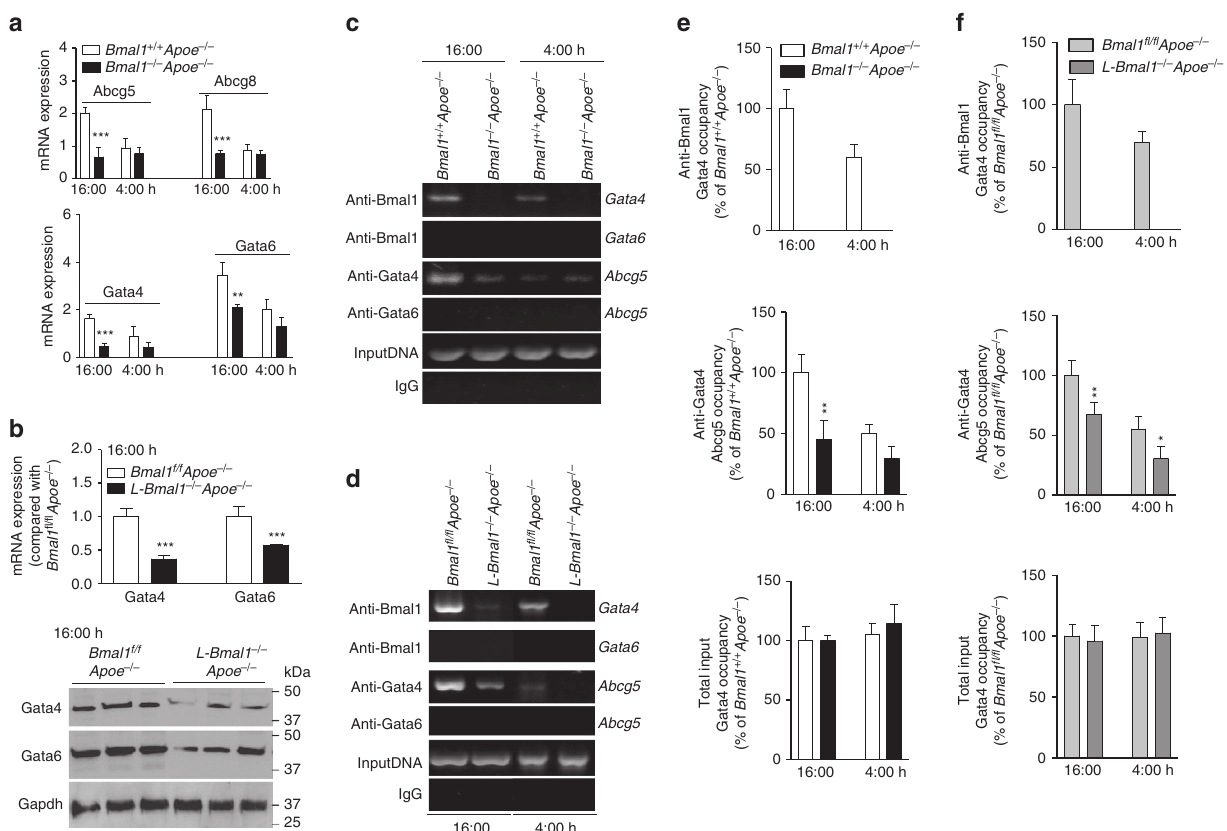
Figure 7 | Bmal1 interacts with the promoter to regulate Gata4 expression. ( a ) Liver samples were collected at 4:00h and 16:00h from Bmal1 (cid:2) / (cid:2) Apoe (cid:2) / (cid:2) and Bmal1 þ / þ Apoe (cid:2) / (cid:2) mice to measure temporal changes in the mRNA levels of Abcg5, Abcg8 (top), Gata4 and Gata6 (down). ( b ) Liver samples were collected at 16:00h from L-Bmal1 (cid:2) / (cid:2) Apoe (cid:2) / (cid:2) and control mice to measure mRNA (top) and protein (bottom) levels of Gata4 and Gata6. ( c ) Liver samples from Bmal1 (cid:2) / (cid:2) Apoe (cid:2) / (cid:2) and Bmal1 þ / þ Apoe (cid:2) / (cid:2) mice were collected at different times to study the binding of different transcription factors using indicated antibodies to the promoters of Gata4 , Gata6 , and Abcg5 genes by ChIP. For this purpose, proteins were cross-linked to DNA, sheared and used to immunoprecipitate protein/DNA complexes using specific antibodies against indicated transcription factors. Sequences in the promoters of Gata4 , Gata6 and Abcg5 were amplified using specific primers (Supplementary Table 1), separated on agarose gels and photographed. Representative of three experiments. ( d ) Liver from Bmal1 fl/fl Apoe (cid:2) / (cid:2) and L-Bmal1 (cid:2) / (cid:2) Apoe (cid:2) / (cid:2) mice were collected at 16:00h and at 4:00h to study the binding of Bmal1, Gata4 or Gata6 to the promoters of Gata4 , Gata6 and Abcg5 genes by ChIP (representative of three different experiments). ( e , f ) Occupancy of Bmal1 on the Gata4 promoter and the occupancy of Gata4 on the Abcg5 promoter was studied by ChIP and then quantified by qRT–PCR in the livers of Bmal1 (cid:2) / (cid:2) Apoe (cid:2) / (cid:2) and Bmal1 þ / þ Apoe (cid:2) / (cid:2) ( e ) and Bmal1 fl/fl Apoe (cid:2) / (cid:2) and L-Bmal1 (cid:2) / (cid:2) Apoe (cid:2) / (cid:2) ( f ) mice. Data in a , b , e and f were examined using